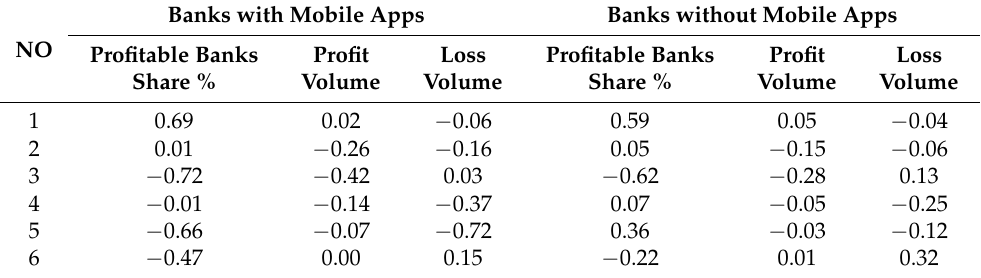
Figure A2. Banks currently proceeding in bankruptcy cases in 2018–2019. Table A1. Estimated correlations.